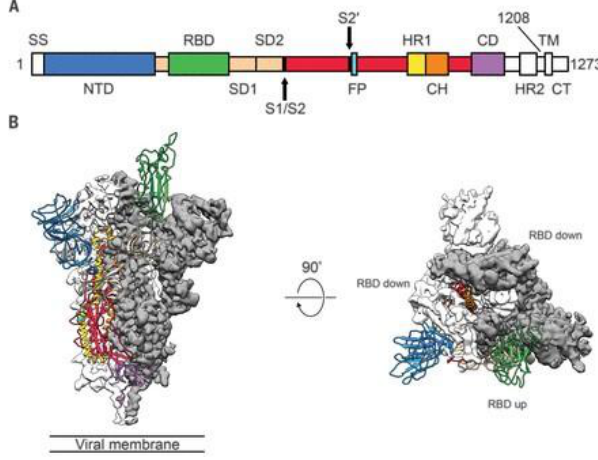
Figure 5: Courtesy reference number25. Structure of SARS-